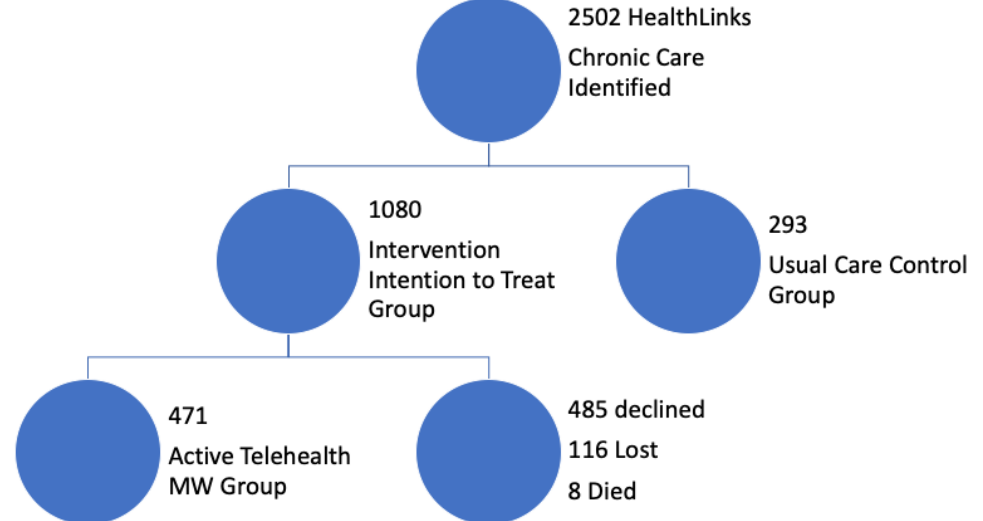
Table 1. Descriptive statistics on admission rates in MonashWatch intention-to-treat and usual care. Description of profiles of those admitted in each